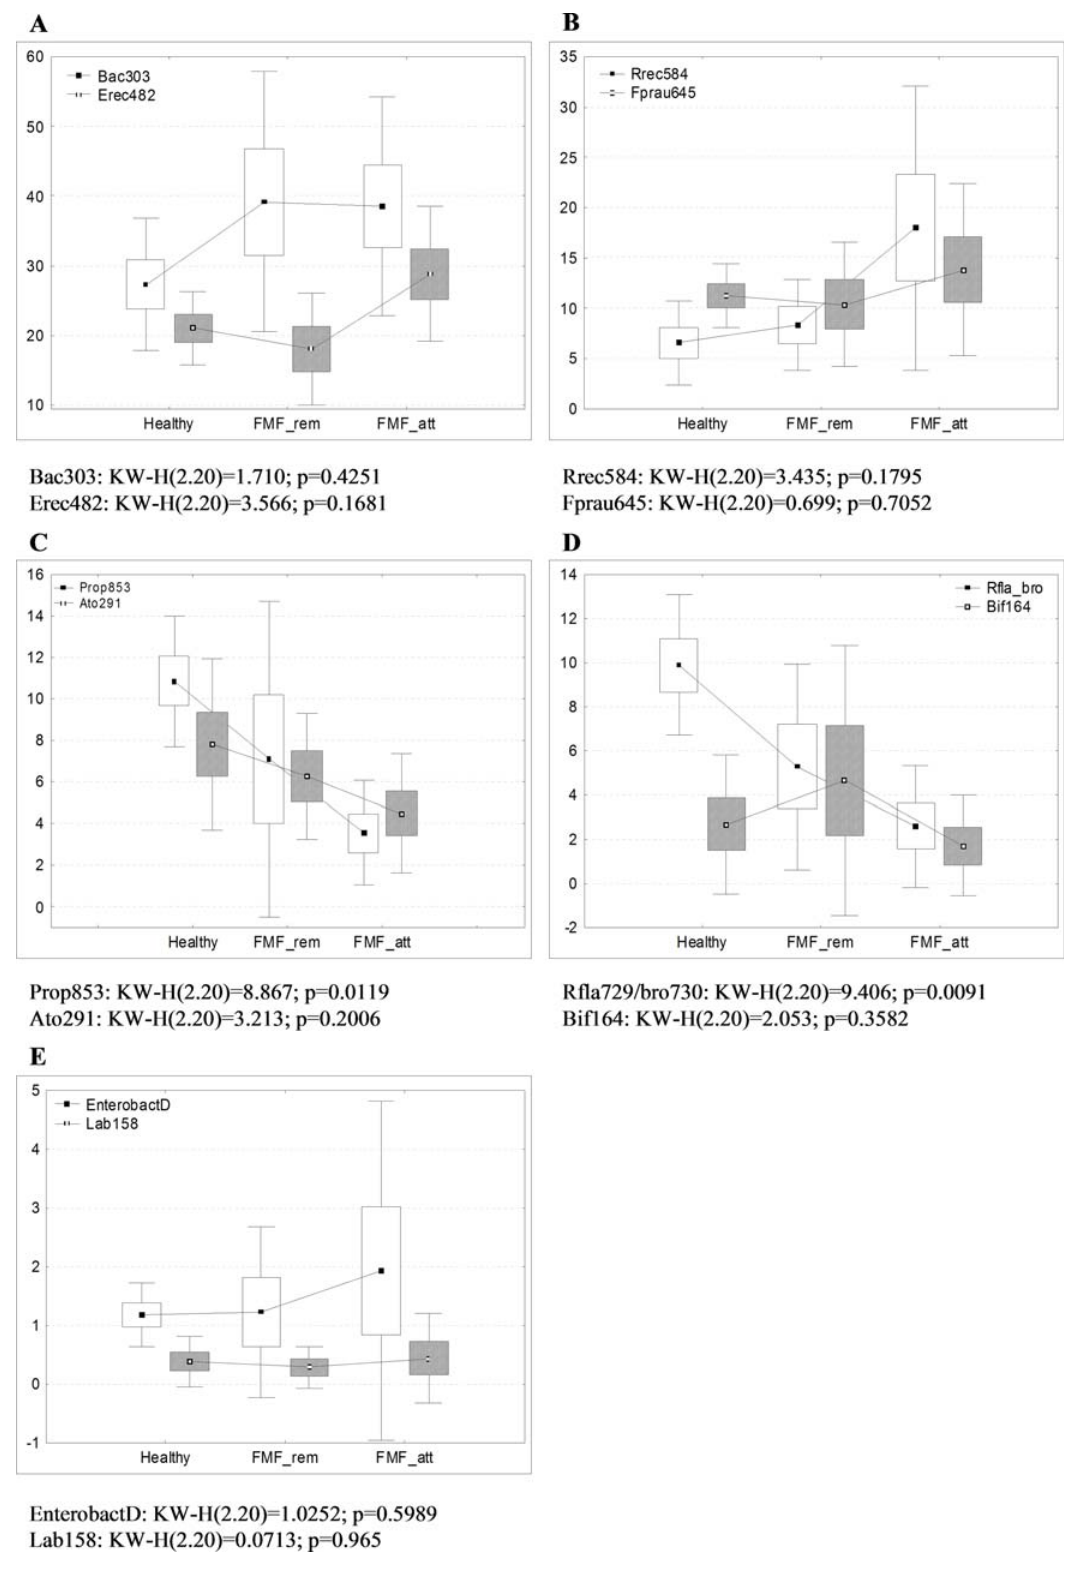
Figure 3. Comparison of the main bacterial groups identified by FISH between healthy and diseased groups. Comparative analysis of relative proportions of bacterial groups detected by different oligonucleotide probes in fecal samples between FMF patients in remission and attack periods and healthy control group (by Kruskal-Wallis test for multiple comparisons). On box-and-whisker plots the points within boxes indicate the mean values of bacterial proportions, the boxes represent standard errors (SE) and the vertical bars represent standard deviations (SD).